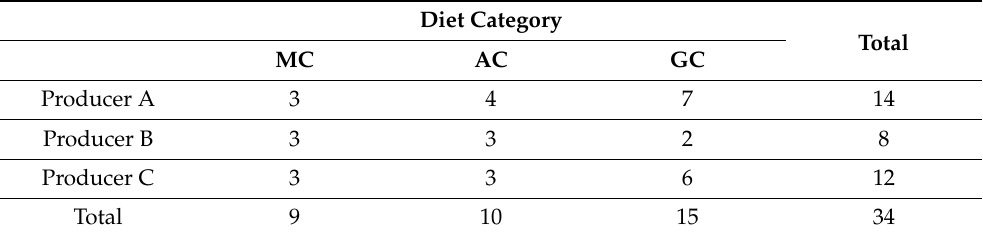
Table 1. The number of products sampled from the ranges proposed by the three manufacturers for the three categories of diets.